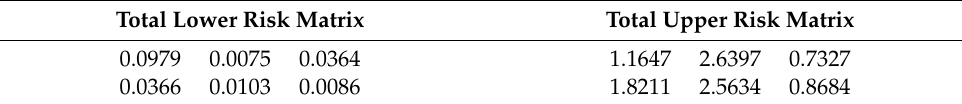
Table 16. Total risk